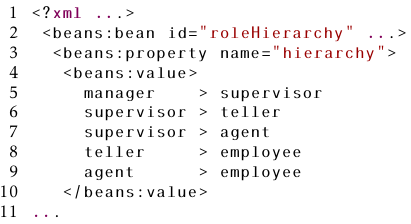
Figure 13. Introducing Mutants in Spring